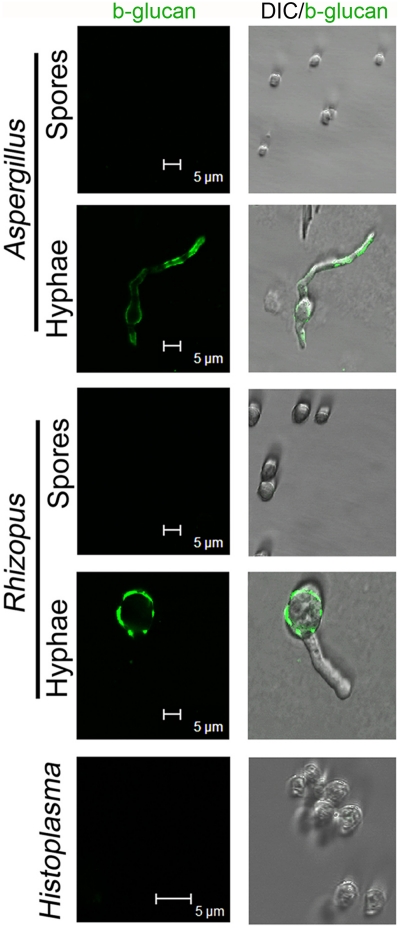
The invasive form of opportunistic fungal pathogens but not that of pathogenic fungi exposes b-glucan in the cell wall surface.Representative confocal microscopy images of b-glucan surface staining of resting (spores) and invasive (hyphae) stages of growth of the opportunistic fungi Aspergillus or Rhizopus and the invasive (yeast) form of the pathogenic fungus Histoplasma. Live fungal cells were fixed with 1% paraformaldehyde and stained with a mouse b-(1–3)-glucan-specific monoclonal antibody followed by staining with a secondary goat anti-mouse Alexa488 antibody (green). The antibody failed to detect surface b-glucan on the spores of opportunistic fungi and in the invasive form of Histoplasma but detected high amounts of the polysaccharide in germinating hyphae of both Aspergillus and Rhizopus (left panels). The overlay images (DIC/b-glucan immunostaining; right panels) indicate the pattern of surface b-glucan staining in the different stages of growth of fungi. Data shown are representative of 3 independent experiments.